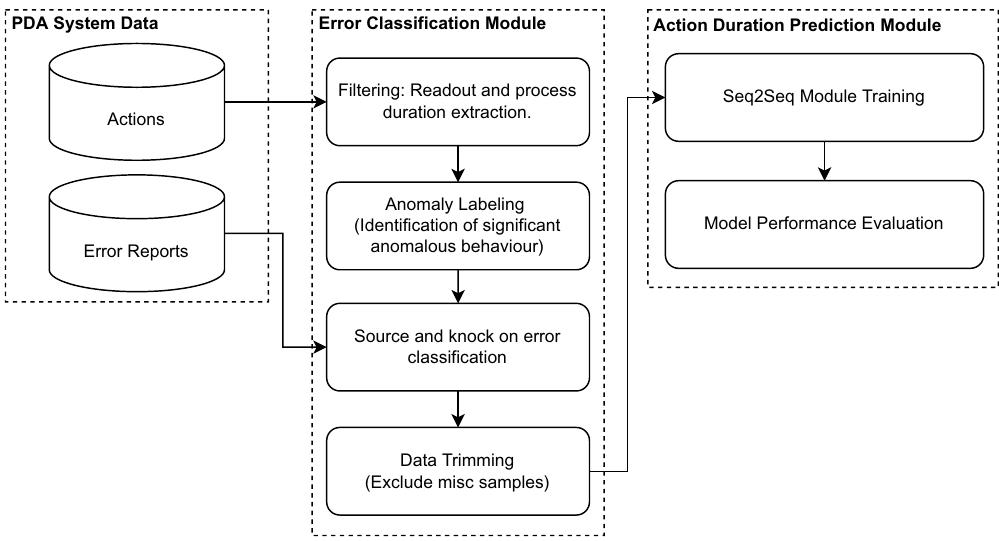
Figure 3. Flowchart of our vehicle manufacturing analyses system (VMAS). First the PDA system data is processed by our Error Classification Module, resulting in four sub-sets: source errors, knock-on errors, normal and misc. The resulting source and knock-on error sets can then be used by our stakeholders for obtaining valuable insights w. r. t. causes of delays. Next, upon excluding misc samples, we use our data for training sequence-to-sequence models for predicting future